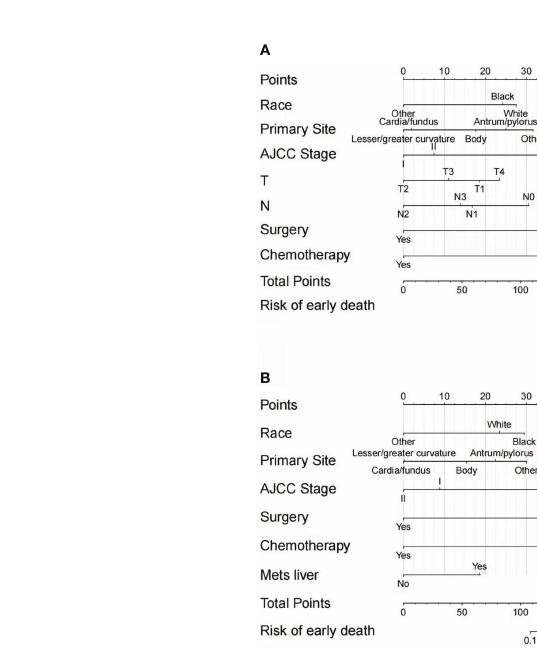
FIGURE 3 Nomograms for predicting all-cause (A) and cancer-speci fi c early death (B) in elderly GC patients.